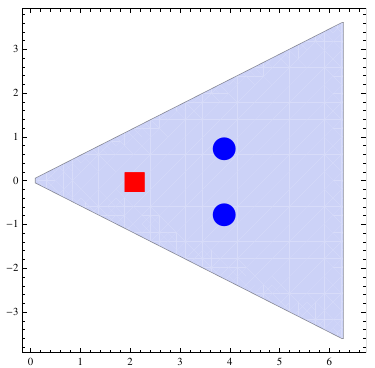
p p (cid:16) (cid:17) (cid:16) (cid:17) 3 3 1 1 ; and (cid:11) 2 = ; (cid:0) . 2 2 2 2 (cid:0) (cid:1) n = 2 . (20)